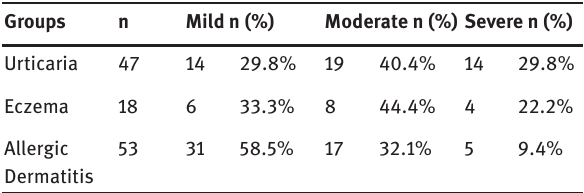
Table 5: Positive rates of different food intolerance degrees.